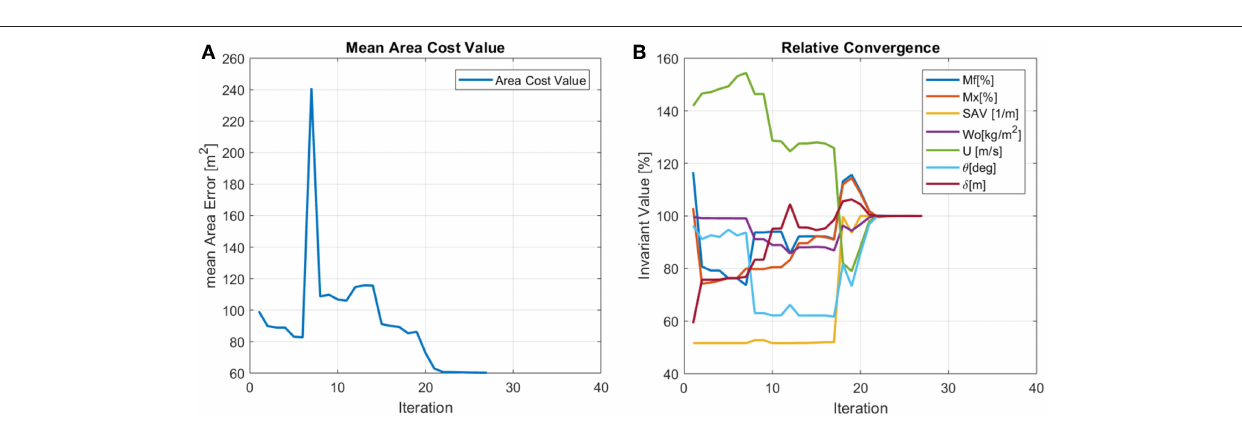
Frontiers in Mechanical Engineering |